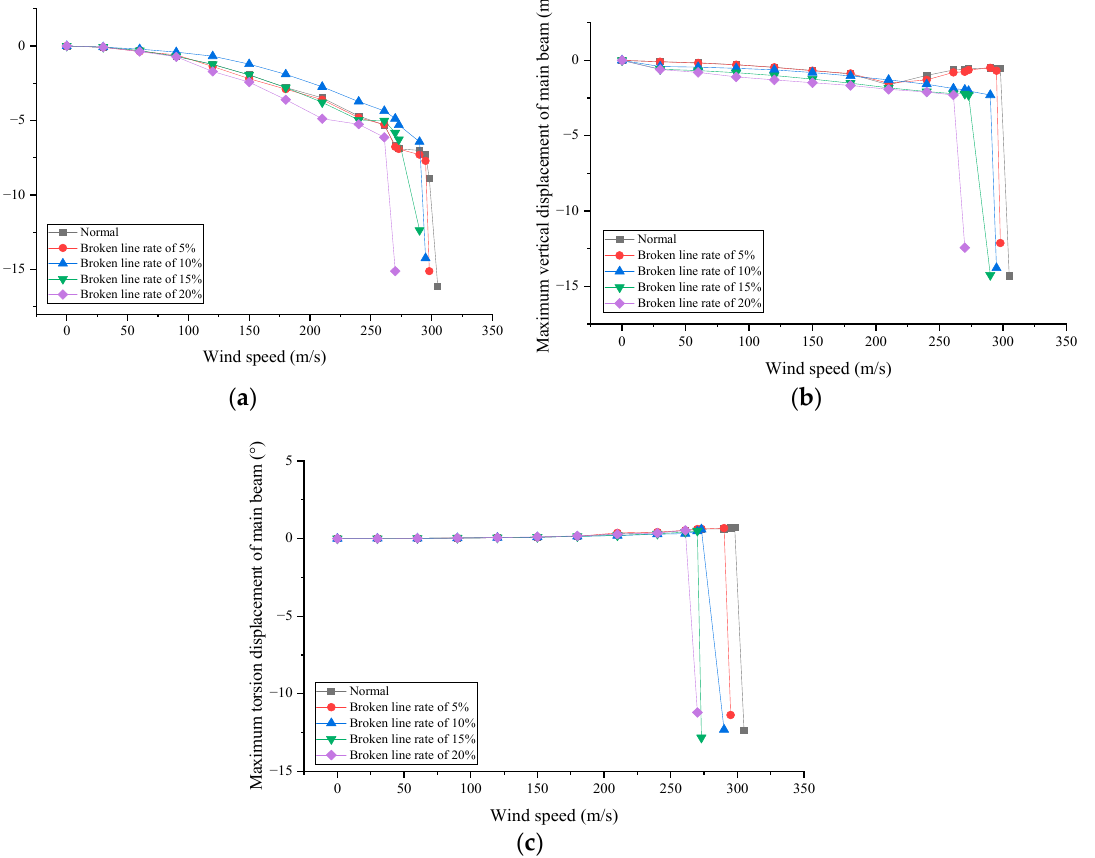
Figure 12. Maximum displacement curve of main beam with wind speed under different wire breakage rates; ( a ) Lateral displacement ( b ) Vertical displacement; ( c ) Torsion angle.